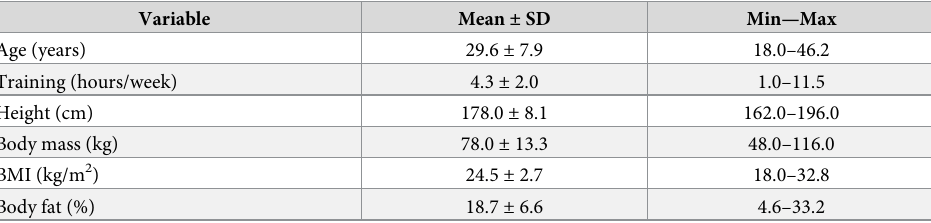
Table 1. Main characteristics of the studied